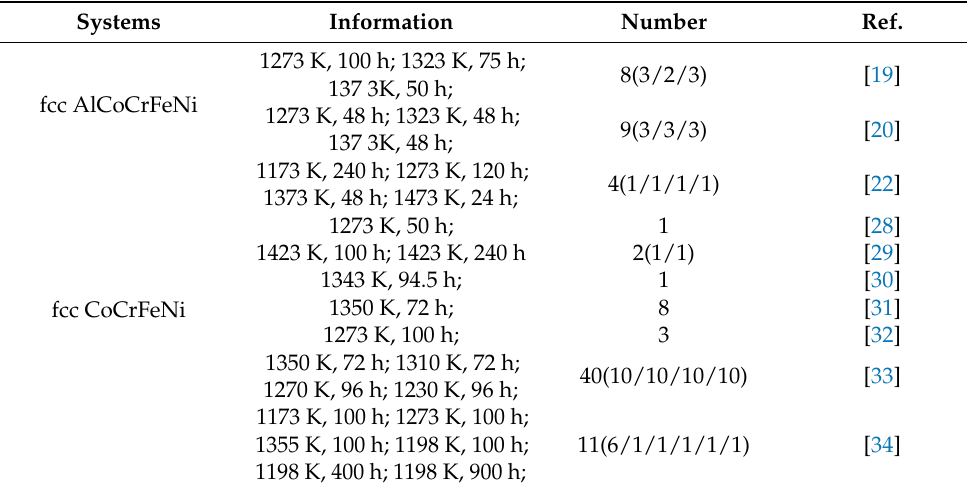
Table 1. List of the employed diffusion couple experimental information (The total number of diffusion couples subject to “Information” column is listed in “Number” column with specific counts in the brackets for different annealing temperature or time).